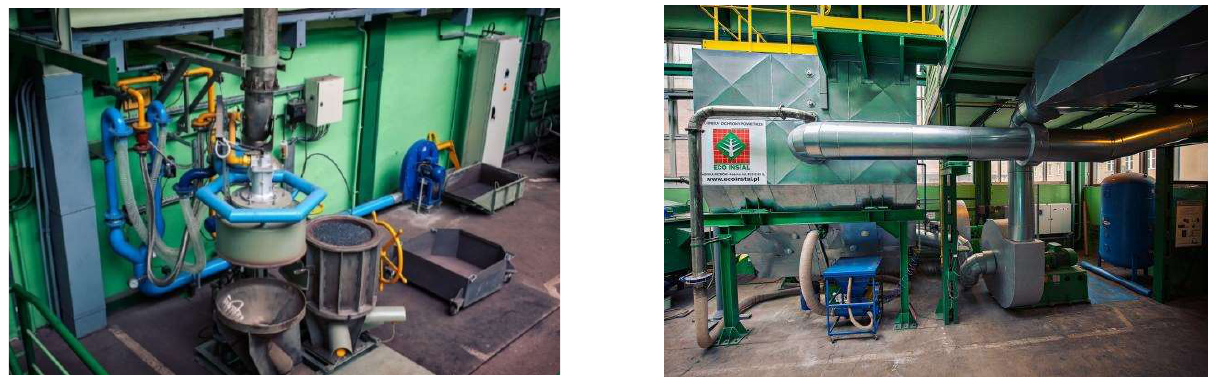
Figure 3. Semi-industrial-scale installation for sintering of iron ores and wastes ( Left ) equipped with a gas cleaning system ( Right ). Table 2. Chemical composition of sintering mixture components.